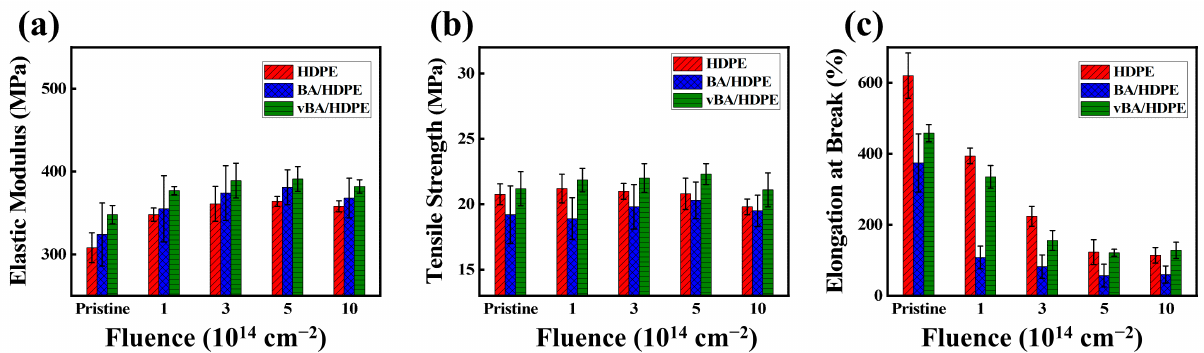
Figure 5. Effect of EB irradiation on modulus of elasticity ( a ), yield strength ( b ), and elongation at break ( c ) of HDPE, BA/HDPE, and vBA/HDPE.